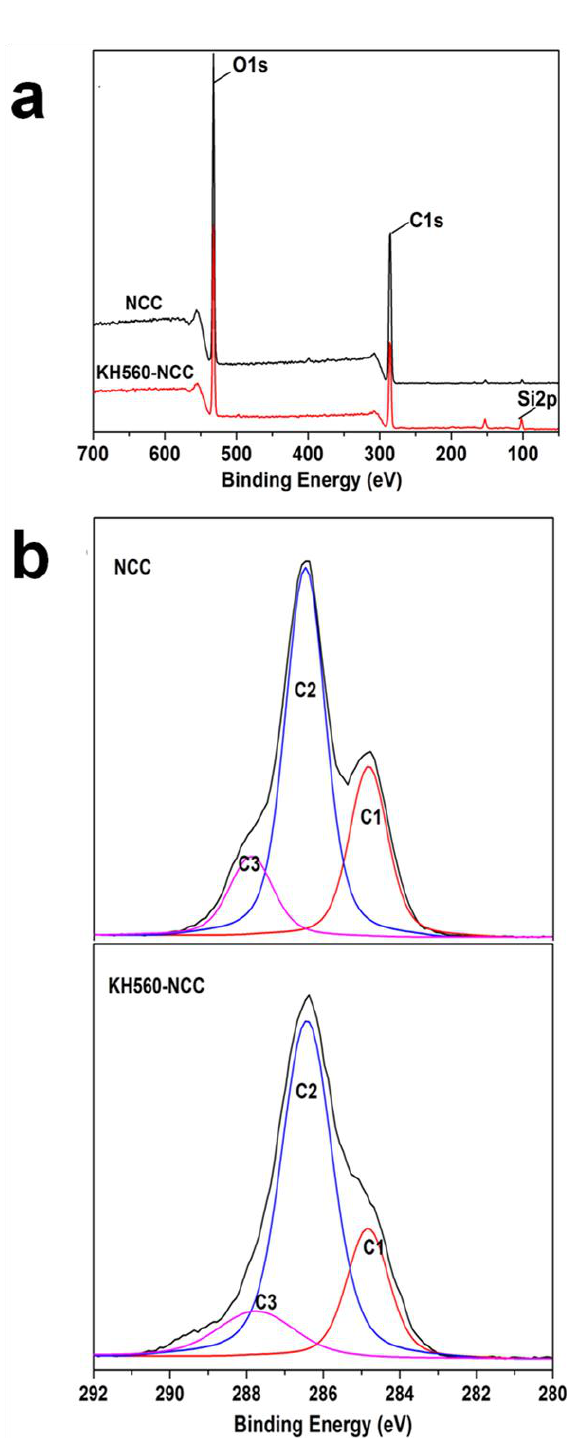
Figure 2. XPS spectra of NCC and KH560-NCC ( a ) and deconvoluted spectra of C1s ( b ). Table 1. XPS analysis of NCC and KH560-NCC.